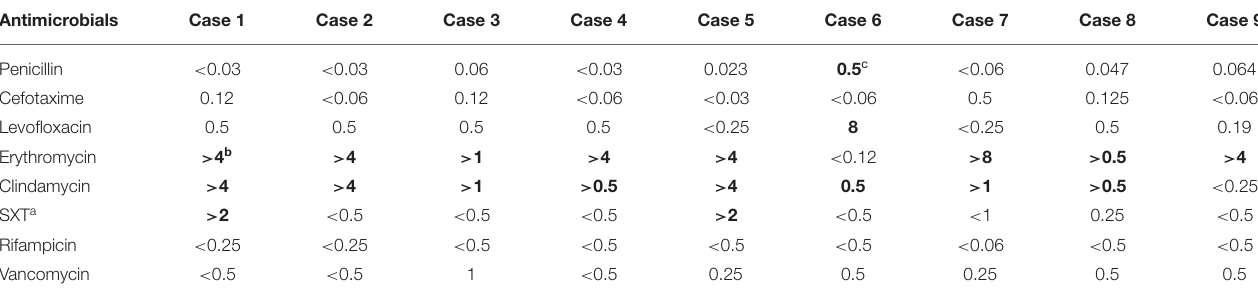
TABLE 2 | Antibiotic MICs of Streptococcus suis .